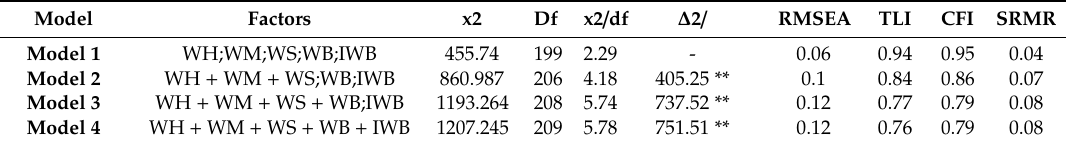
Table 2. Confirmatory Factor Analysis.